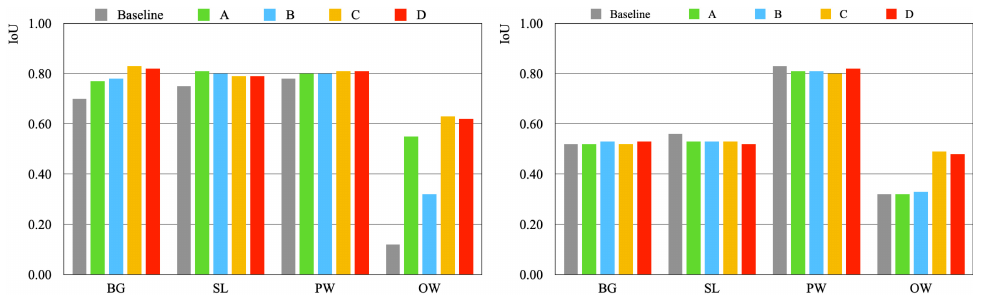
Figure 27. Comparison results of IoU scores in each class: training dataset ( left ) and test dataset ( right